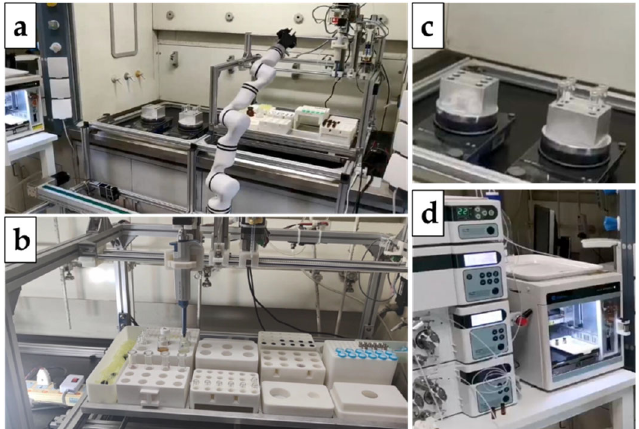
Figure 4. Illustration of an unmanned chemical system, where ( a ) is the robotic arm, ( b ) is the pipetting station, ( c ) is the reacting region, ( d ) is the characterization module (e.g., HPLC).